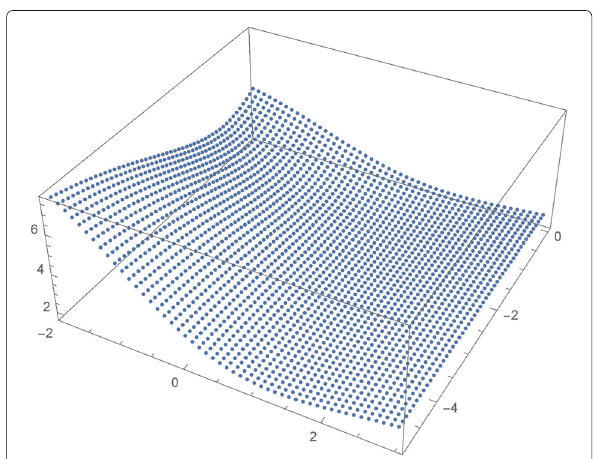
Fig. 2 Variance of the procurement cost V [ C ]. This figure is a 3D plot of the variance of the procurement cost E [ C ]